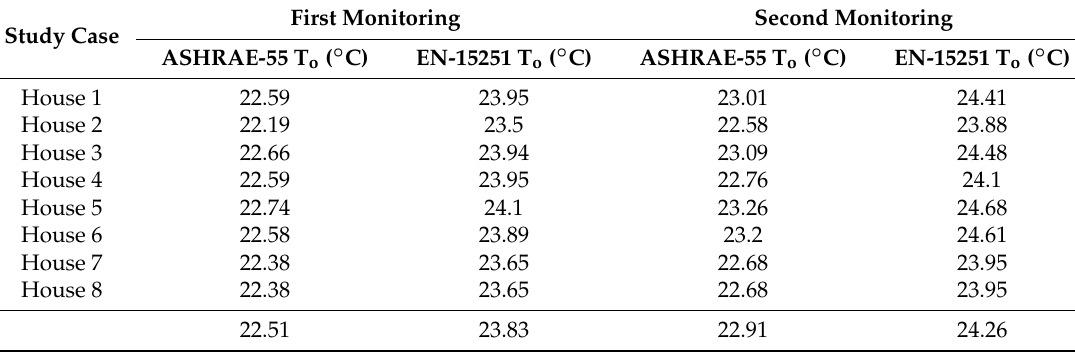
Figure 8. TSV according to the indoor temperature and T n calculation via linear regression. Data from: Applied questionnaires and environmental monitoring. Table 4. Operative temperature values according to ASHRAE-55 and EN-15251 regulations for each studied case.